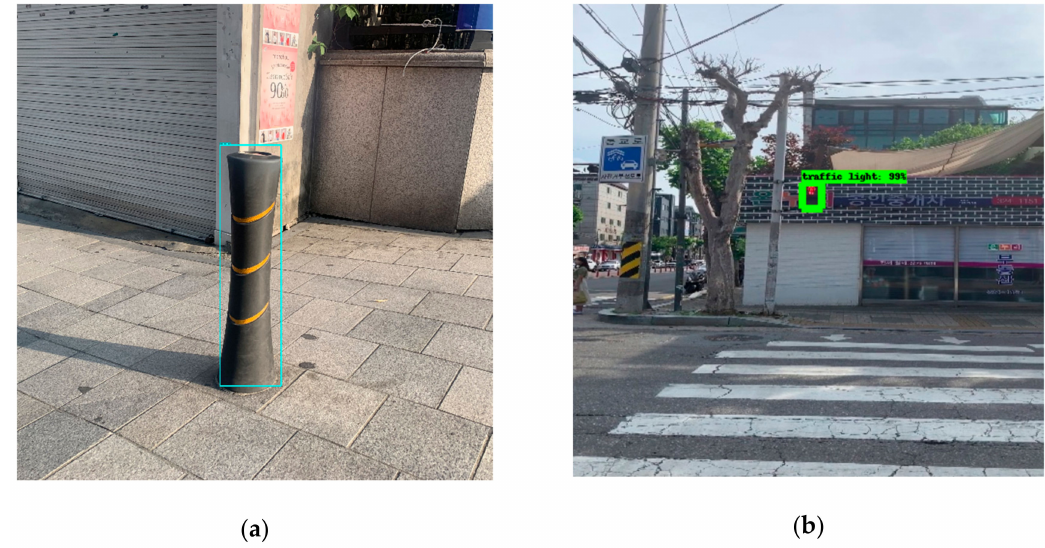
Figure 6. Display screens recognizing obstacles utilizing the proposed model: ( a ) bollard detection; ( b ) crosswalk light detection.